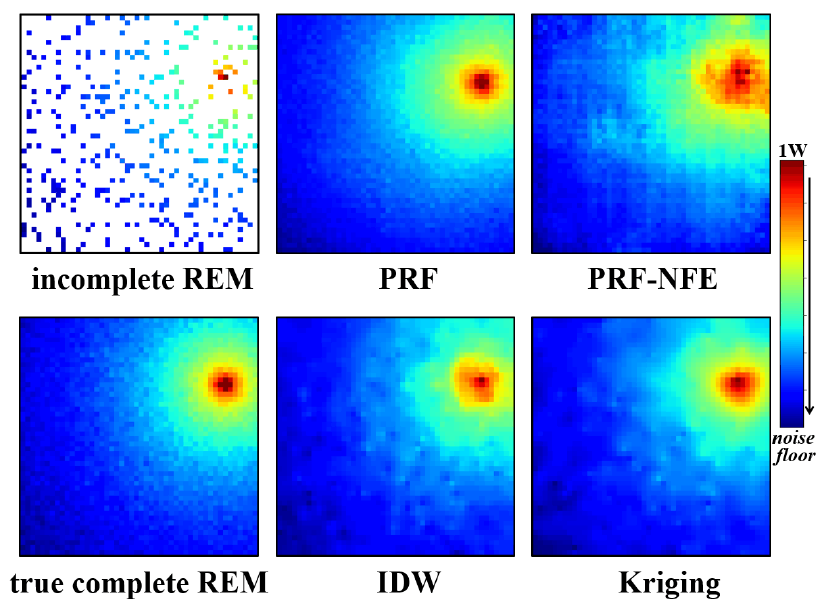
Figure 11. The incomplete radio environment maps, PRF, PRF without the feature enhancing module, IDW, Kriging with the exponential semi-variogram estimation results and the true, complete radio environment map for PU2 at 75 MHz.